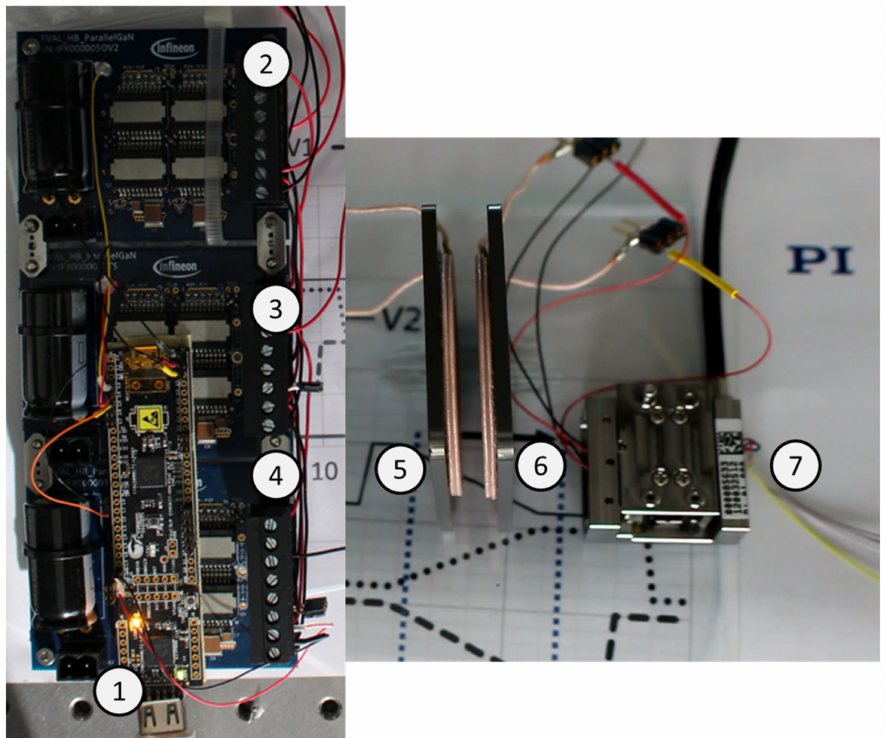
Figure 9. First step to a cableless positioning stage. Prototype wireless driving electronics of a two-phase piezoelectric inertia-type motor. 1—microcontroller, 2—Booster to convert DC 24 V to 40 V, 3—GaN-Tr Half bridge, 4—GaN-Tr Half bridge, 5—Transmitter coil, 6—Receiver Coil, 7—Positioning stage.